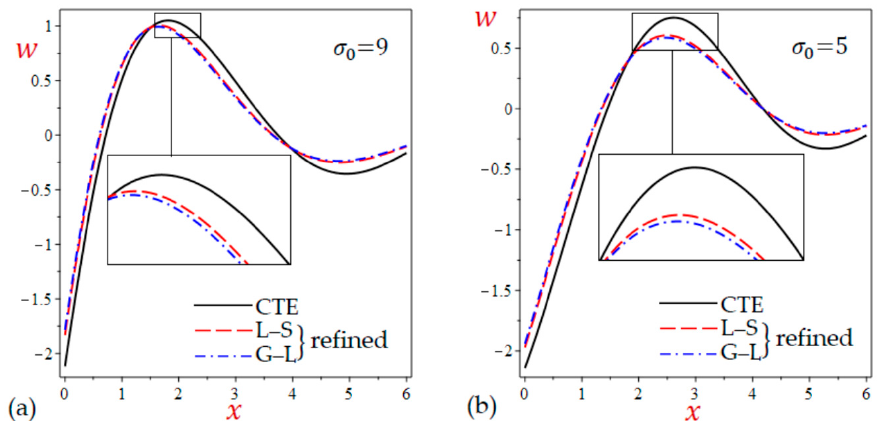
Figure 3. Effect of initial stress σ 0 on the vertical displacement w of the rotating half-space with initial pressure ( (cid:112) = 10) ( a ) σ 0 = 9; ( b ) σ 0 = 5.